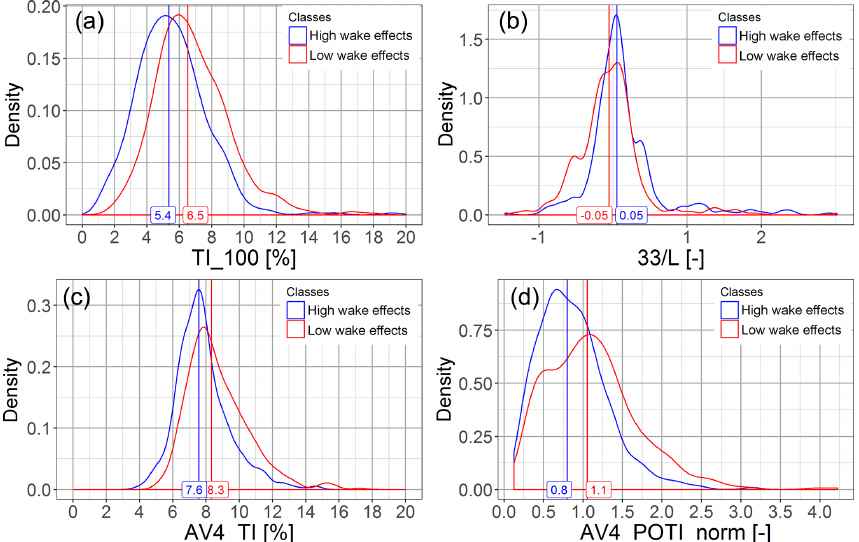
Figure 14. The thresholds displayed as vertical lines representing the median of the density distribution for the signal of interest.